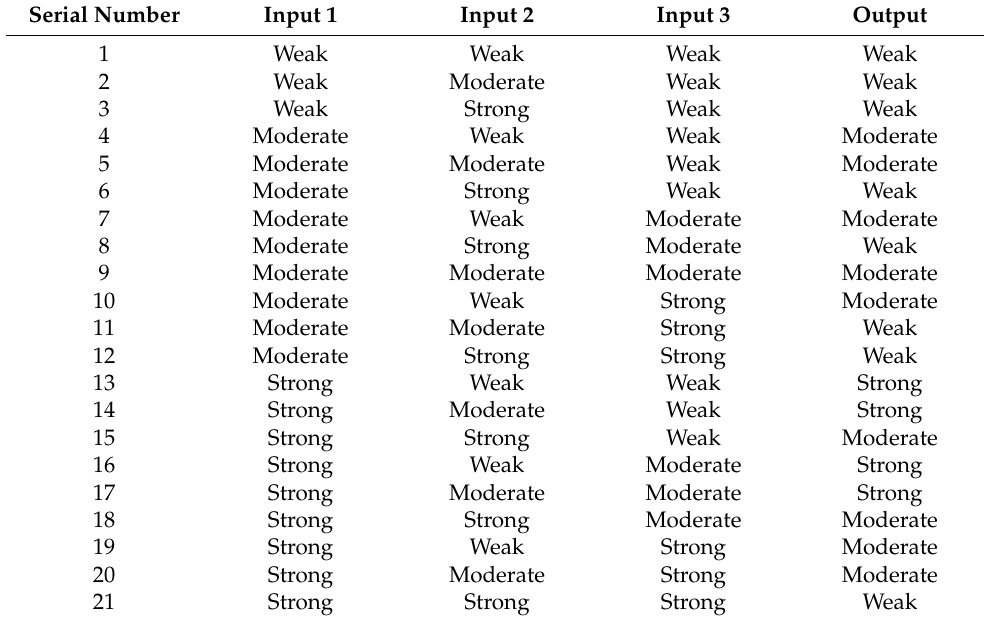
Table 2. Temporal correlation rules of fuzzy system